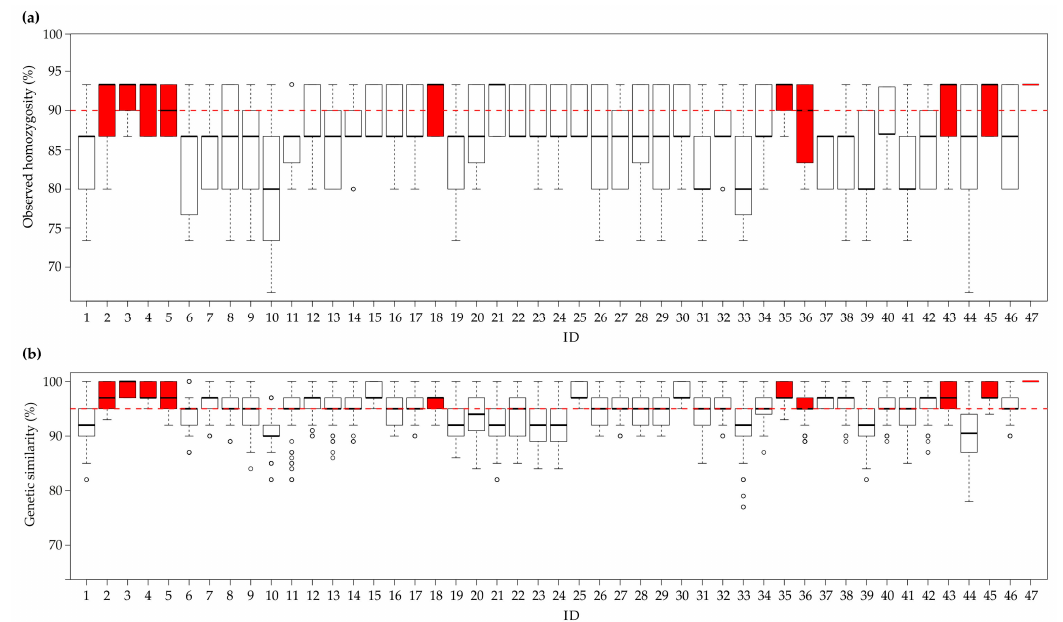
Figure 4. Statistics relating to the observed homozygosity and genetic similarity among lines. ( a ) Box-plot of the median observed homozygosity (in percentages) in each of the 47 populations. The red dotted line represents the homozygosity threshold set at 90%. ( b ) Box plot of the median genetic similarity in each experimental population (in percentages). The red dotted line represents the genetic similarity threshold set at 95%. The red box-plots represent the ten best experimental populations (observed homozygosity ≥ 90% and genetic similarity values ≥ 95%). The second and third quartiles are marked inside the square and are divided by a bold bar (median). Dots show outlier samples.